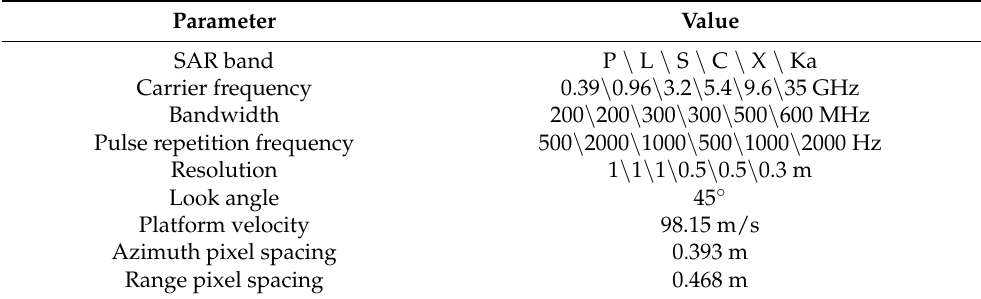
Table 1. Main parameters of DVD-InSAR